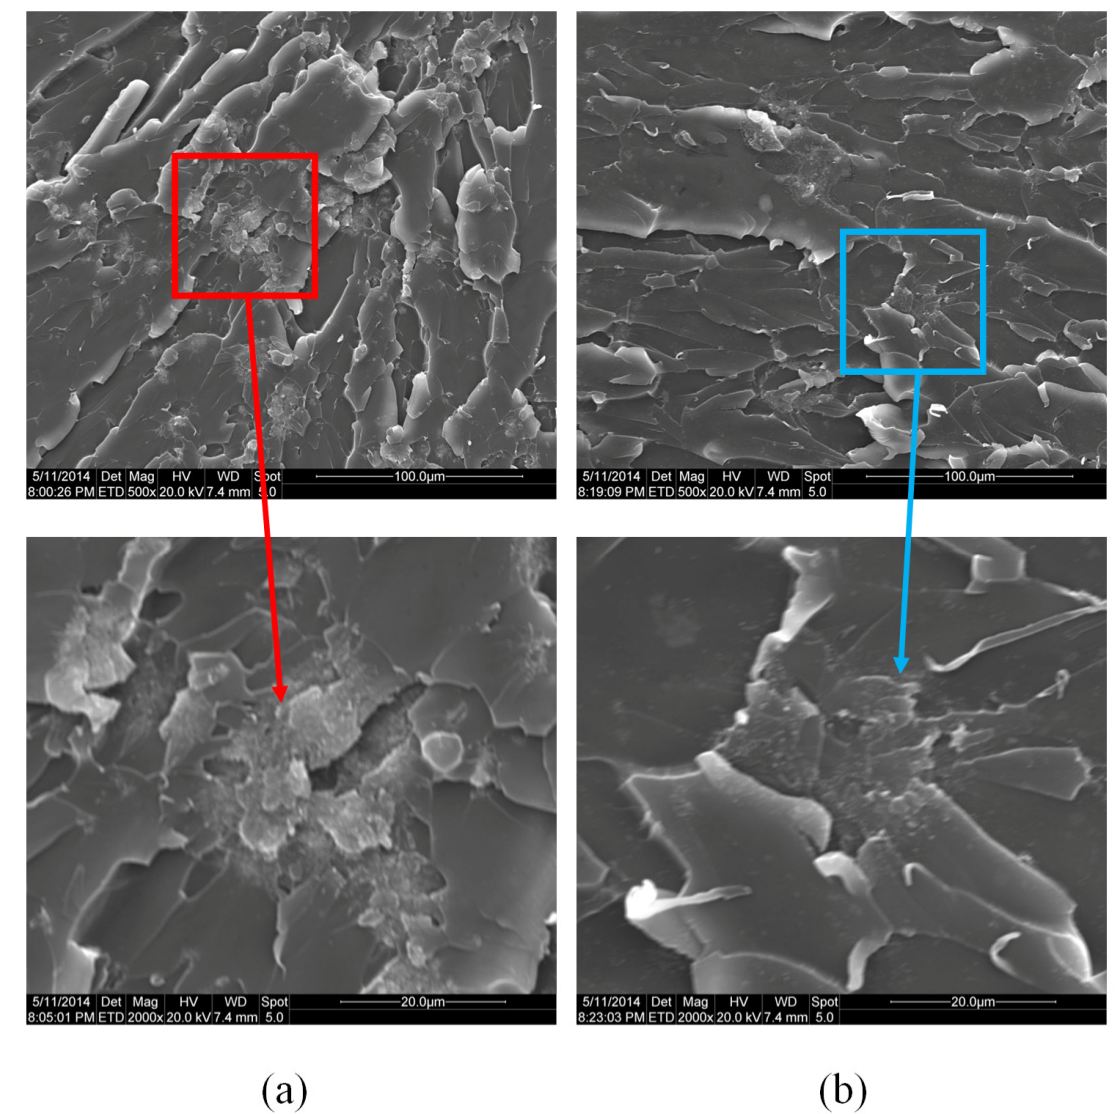
Figure 11. SEM images of ( a ) CNTs and ( b ) CNTs-PMDA in the EP matrix.